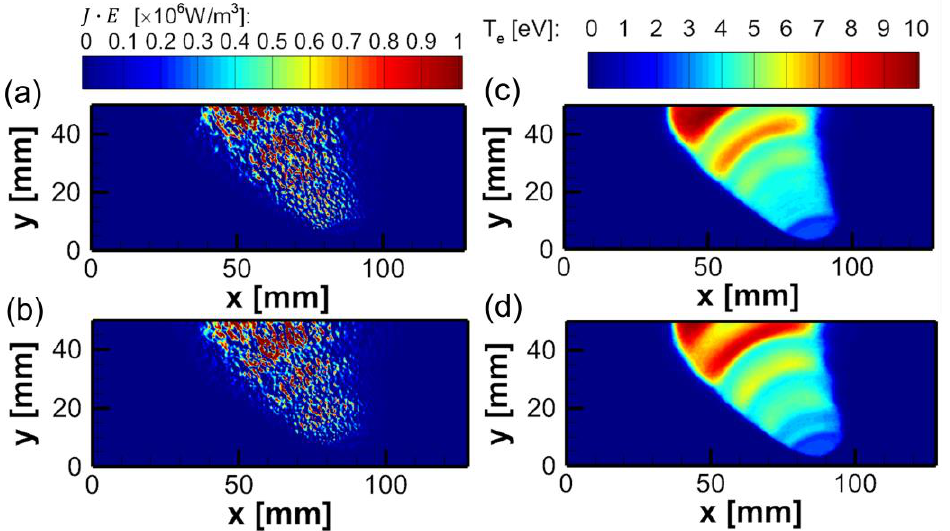
Figure 7. Profiles of 𝐽 ∙ 𝐸 with the yoke thickness of ( a ) 10 mm and ( b ) 15 mm . Profiles of electron temperatures with the yoke thickness of ( c ) 10 mm and ( d ) 15 mm .